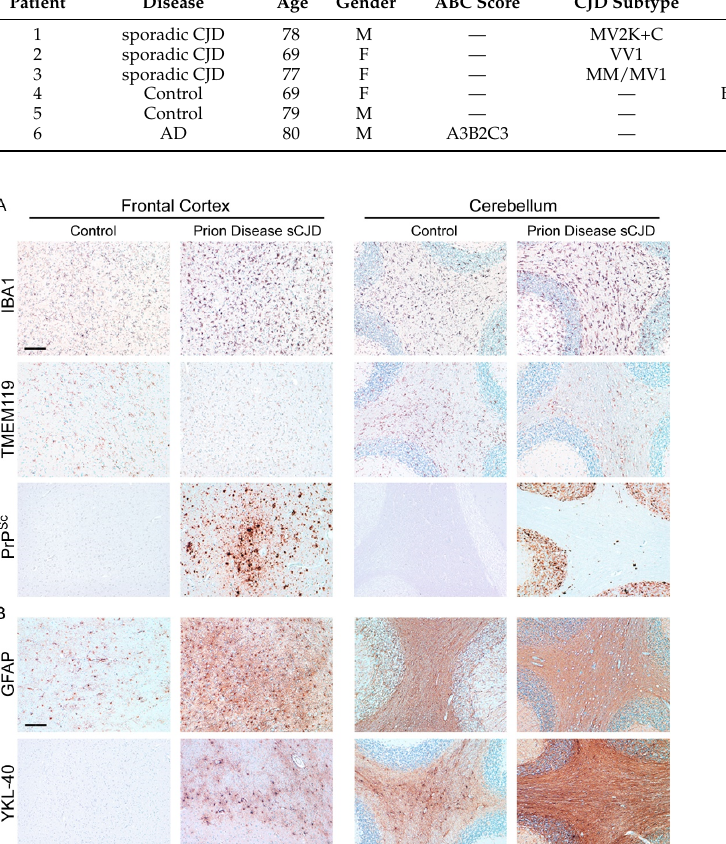
Figure 6. Glia cells are highly dysregulated in human sCJD. Human brain tissues are usually fixed in 4% buffered formalin. To inactivate prion infectivity, tissues should be incubated in 98% formic acid for 1.5 h. Tissues from healthy human controls should be similarly treated with formic acid, to enable identical staining conditions. Frontal cortex and cerebellum brain sections from sCJD patients and control patients without neurologic disease are shown for ( A ) the pan-microglia/macrophage marker IBA1 and homeostatic microglia marker TMEM119 [97]. Note that while IBA1+ microglia are increased in sCJD staining, the intensity of TMEM119 staining is reduced compared to an age- matched non-demented control patient [97]. Deposits of misfolded PrP Sc (sCJD) are also shown. Scale bar: 200 µm. ( B ) Besides microglia, astrocytes are also highly dysregulated in prion diseases such as sCJD [97,107], as displayed by the astrocyte markers GFAP and YKL-40 for an sCJD case and an age-matched control. Scale bar: 200 µm.